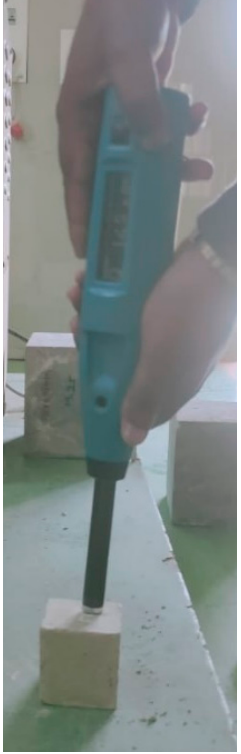
Figure 3. Calibration of rebound hammer equipment.